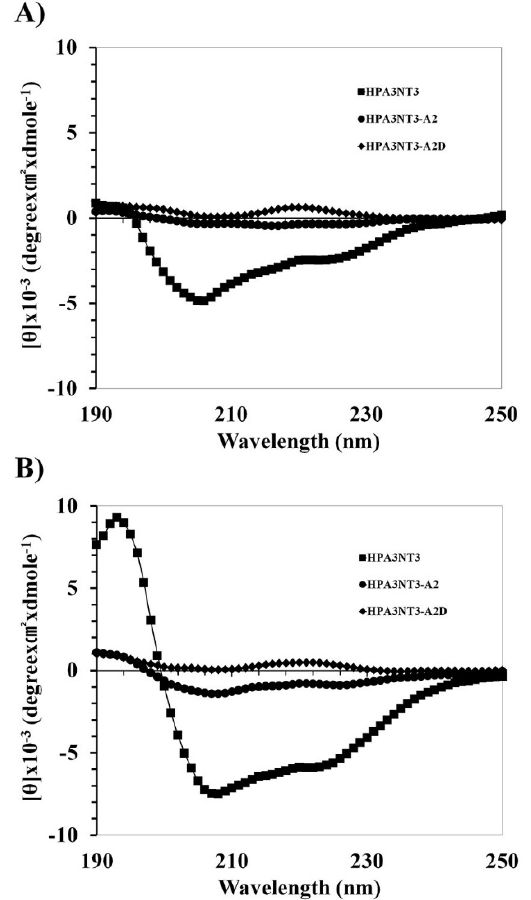
Figure 3. Binding a ffi nity activity of the HPA3NT3, HPA3NT3-A2, and HPA3NT3-A2D peptide from Figure 3. Binding affinity activity of the HPA3NT3, HPA3NT3-A2, and HPA3NT3-A2D peptide from PE / PG (7:3, w / w ) ( A ) or PC / SM (2:1, w / w ) ( B ) small unilamellar vesicle (SUV) liposomes. Mean values PE/PG (7:3, w / w ) ( A ) or PC/SM (2:1, w / w ) ( B ) small unilamellar vesicle (SUV) liposomes. Mean values are presented; n = are presented; n = 3.